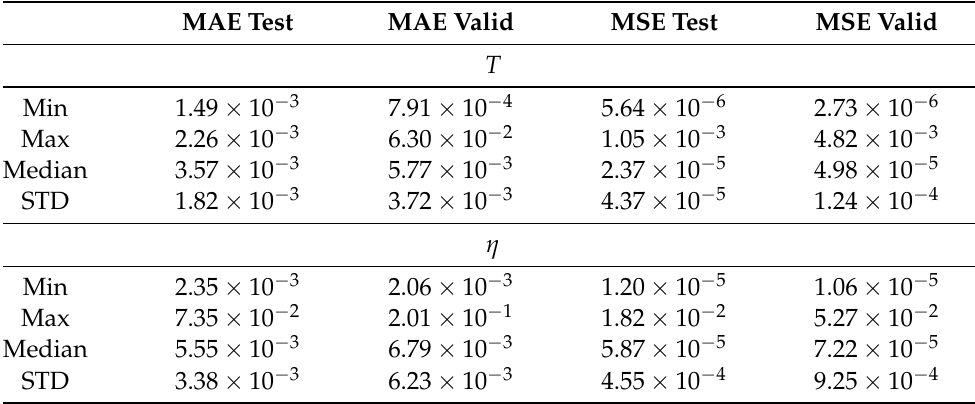
Figure 11. Monte Carlo Training convergence evaluation. Table 8. Training network